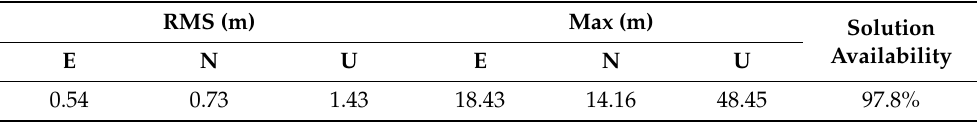
Figure 11. Positioning results (top) and the related position errors (bottom), both expressed in the east (E), north (N), and vertical (U) directions. Table 2. Statistical properties of the positioning results for the root mean square (RMS) error, absolute maximum (Max) error, and solution availability.